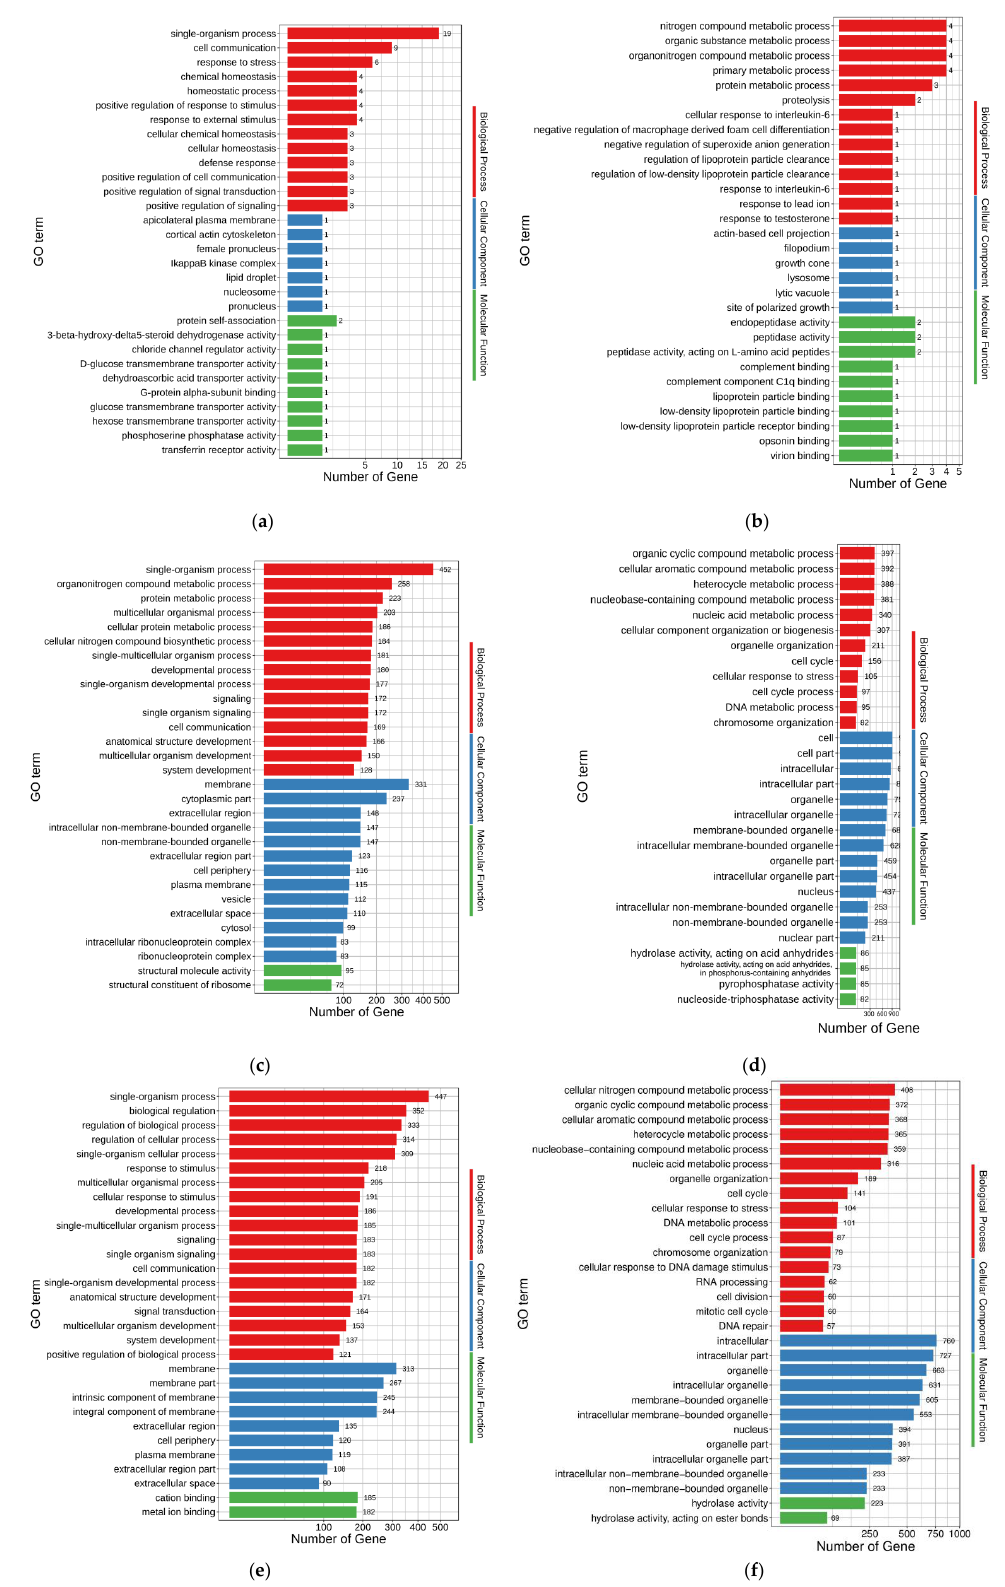
Figure 3. Top 30 enriched GO terms for DEGs. ( a ) Up-regulated DEGs of MT-vs.-PMT. ( b ) Down- regulated DEGs of MT-vs.-PMT, ( c ) Up-regulated DEGs of FO-vs.-MT. ( d ) Down-regulated DEGs of FO-vs.-MT. ( e ) Up-regulated DEGs of FO-vs.-PMT. ( f ) Down-regulated DEGs of FO-vs.-PMT. The up- and down-regulated DEGs of FO-vs.-MT enriched 696 and 452 GO terms ( p < 0.05), respectively (Supplementary Tables S4 and S5). The top 30 enriched GO terms for up- and down-regulated DEGs of FO-vs.-MT are shown in Figure 3c,d, respectively. In the up-regulated DEGs, single-organism process (GO:0044699), organonitrogen com- pound metabolic process (GO:1901564), protein metabolic process (GO:0019538), multi- cellular organismal process (GO:0032501), and cellular protein metabolic process